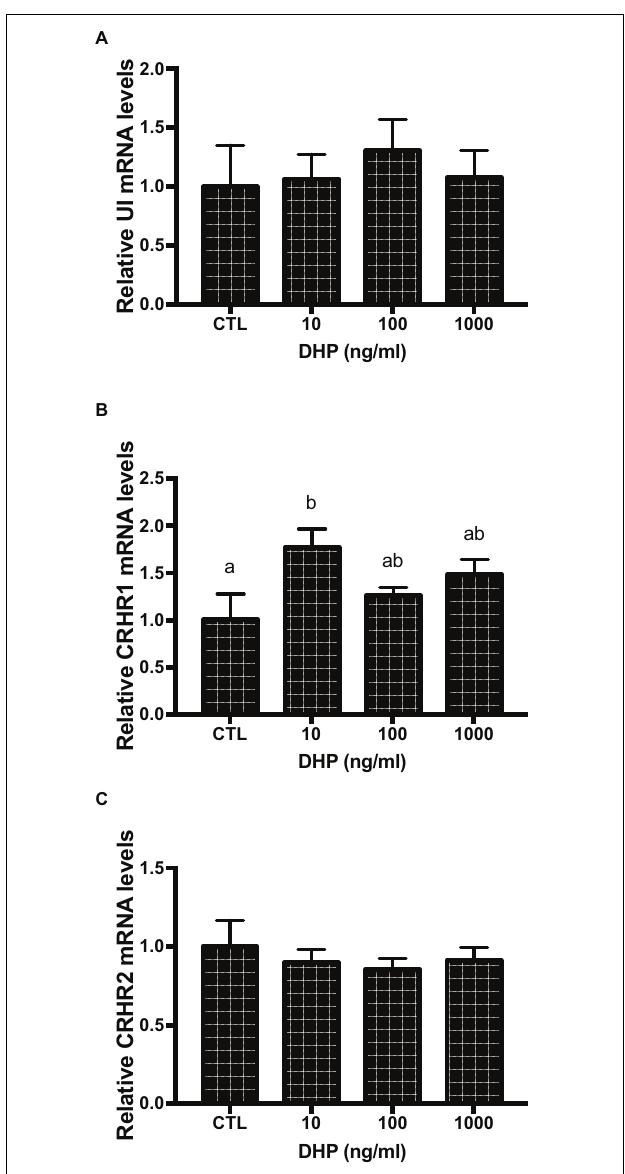
FIGURE 6 | mRNA expression for UI (A) , CRHR1 (B) , and CRHR2 (C) mRNA in the stage IV follicles induced by DHP for 9 h in vitro . Data were presented as the fold change relative to control group, which was arbitrarily set at 1. Values are means ± SEM, n = 6 per group. Means with different letters within a column are significantly different P <